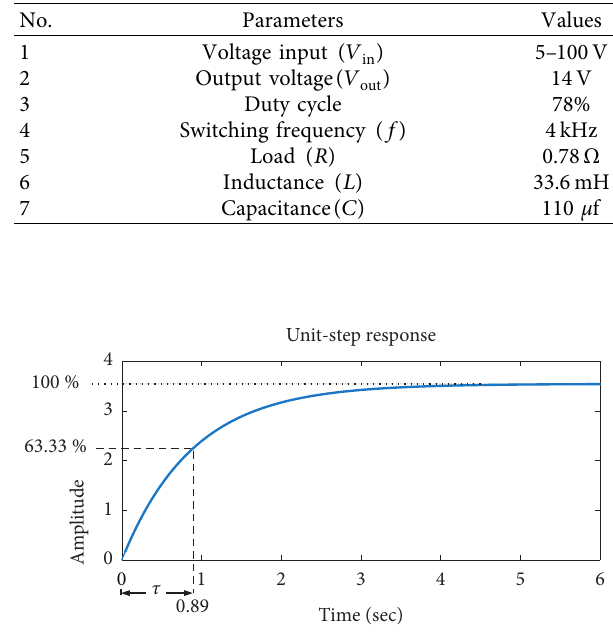
Figure 5: Open loop response of buck-boost